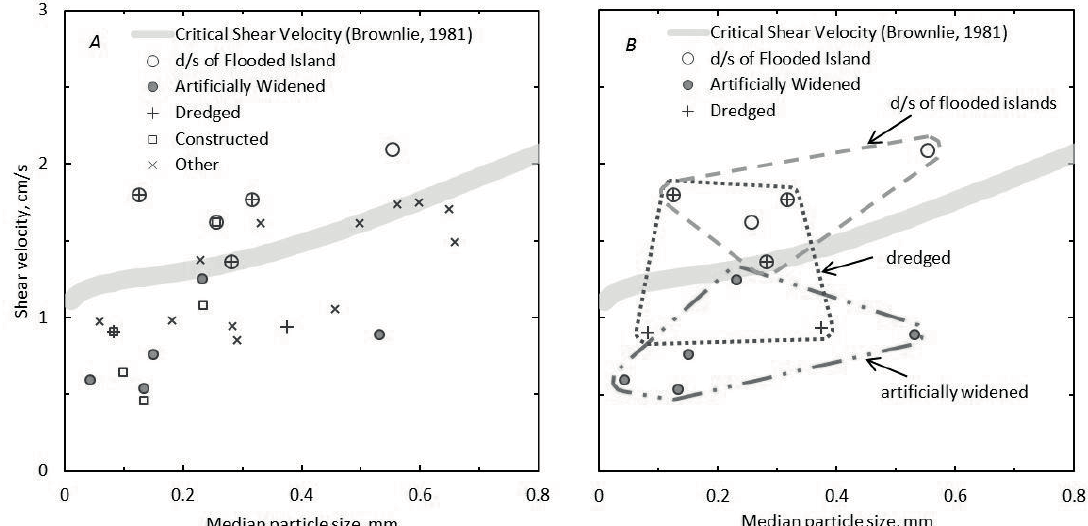
Fig. 2 Median shear velocity calculated for each study site in the Delta with channel type indicated (A), and with groups of selected channel types outlined (B). Note: some sites are characterized by two channel